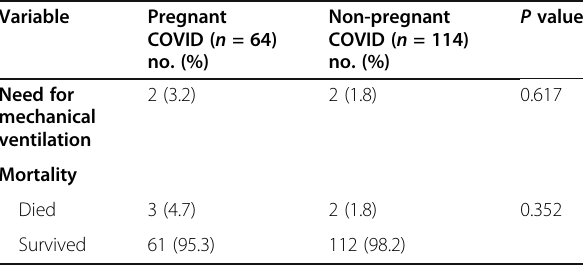
Table 3 Comparison between the pregnant COVID-19 and non- pregnant COVID-19 patients regarding the main clinical disease-